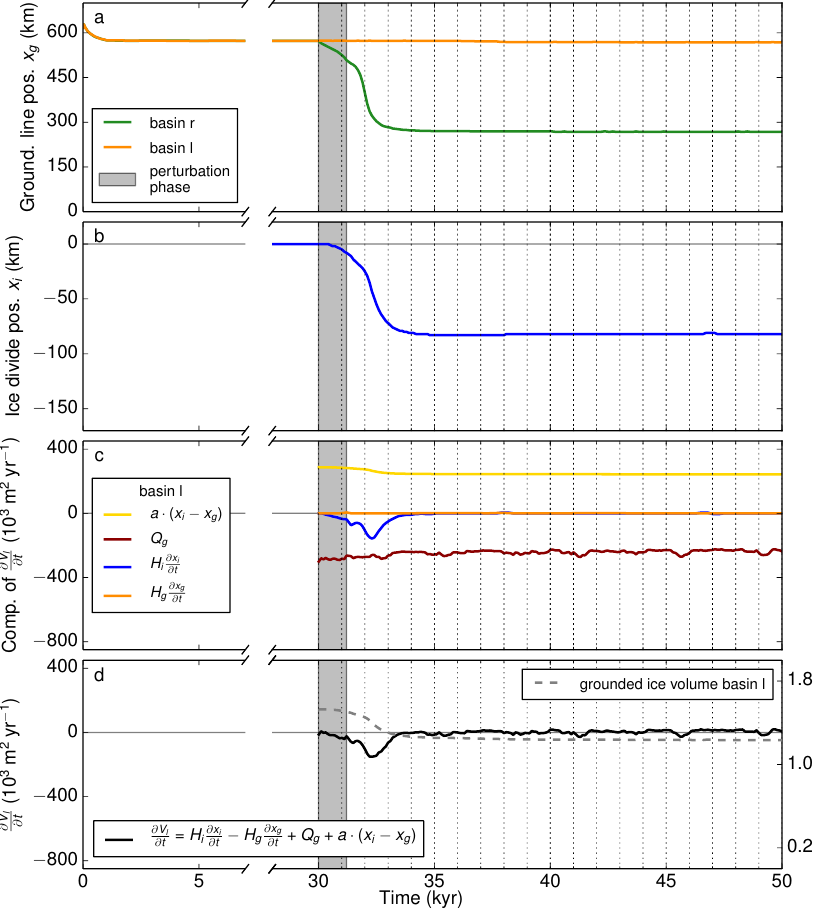
Figure 6. Same as Fig. 5 but here for the stable scenario S (simulation BC+400, see Fig.